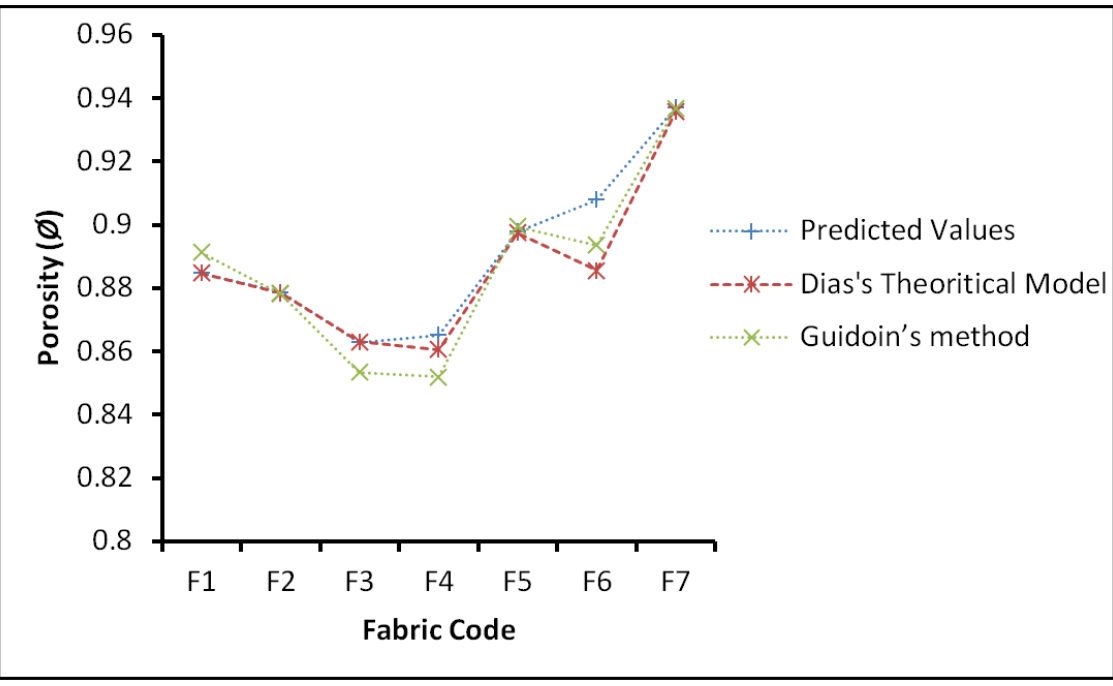
Figure 9. Porosity comparison of plug-in predicted results with other